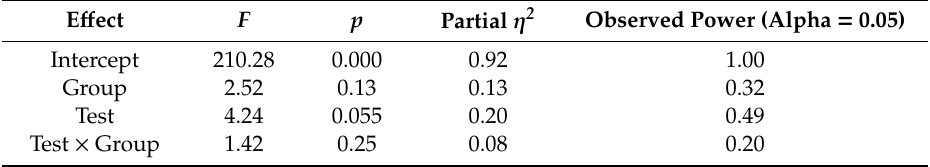
Table 6. Results of two-way repeated measure ANOVA with practice conditions (two levels: CG and VG) as a between-participants factor and test type (two levels: pre and posttest) as a within-participants factor. Provided: F -values, p -values, and partial eta-squared ( η 2 ) as a measure of the e ff ect size. E ff ect F p Partial η